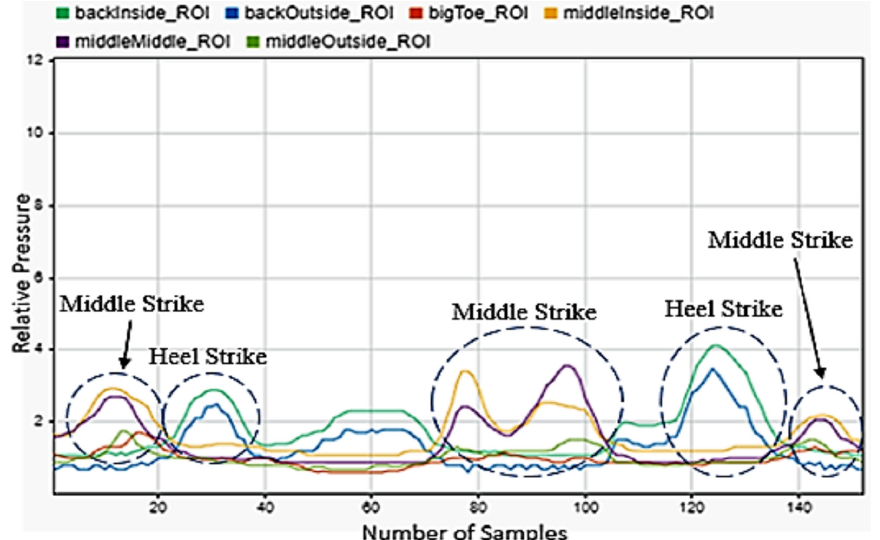
Figure 8. Stoop with right foot forward sensor readings for the left foot.